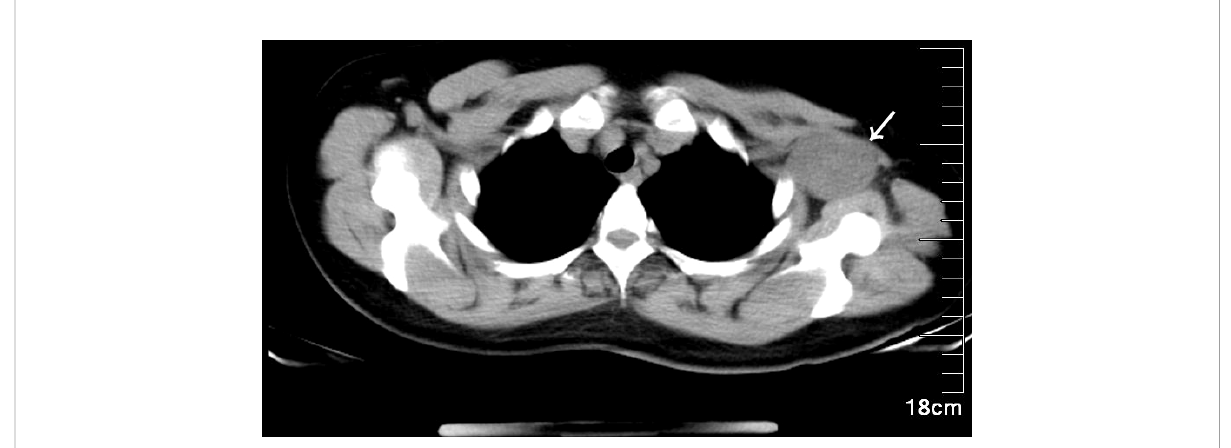
FIGURE 2 A mediastinal window with 16-slice spiral CT showed that the left axilla had a slightly circular and low-density shadow, with a cross-sectional area of approximately 33 mm × 47 mm and a CT value of approximately 33 HU. The mass was closely related to the chest wall, with a slender pedicle faintly